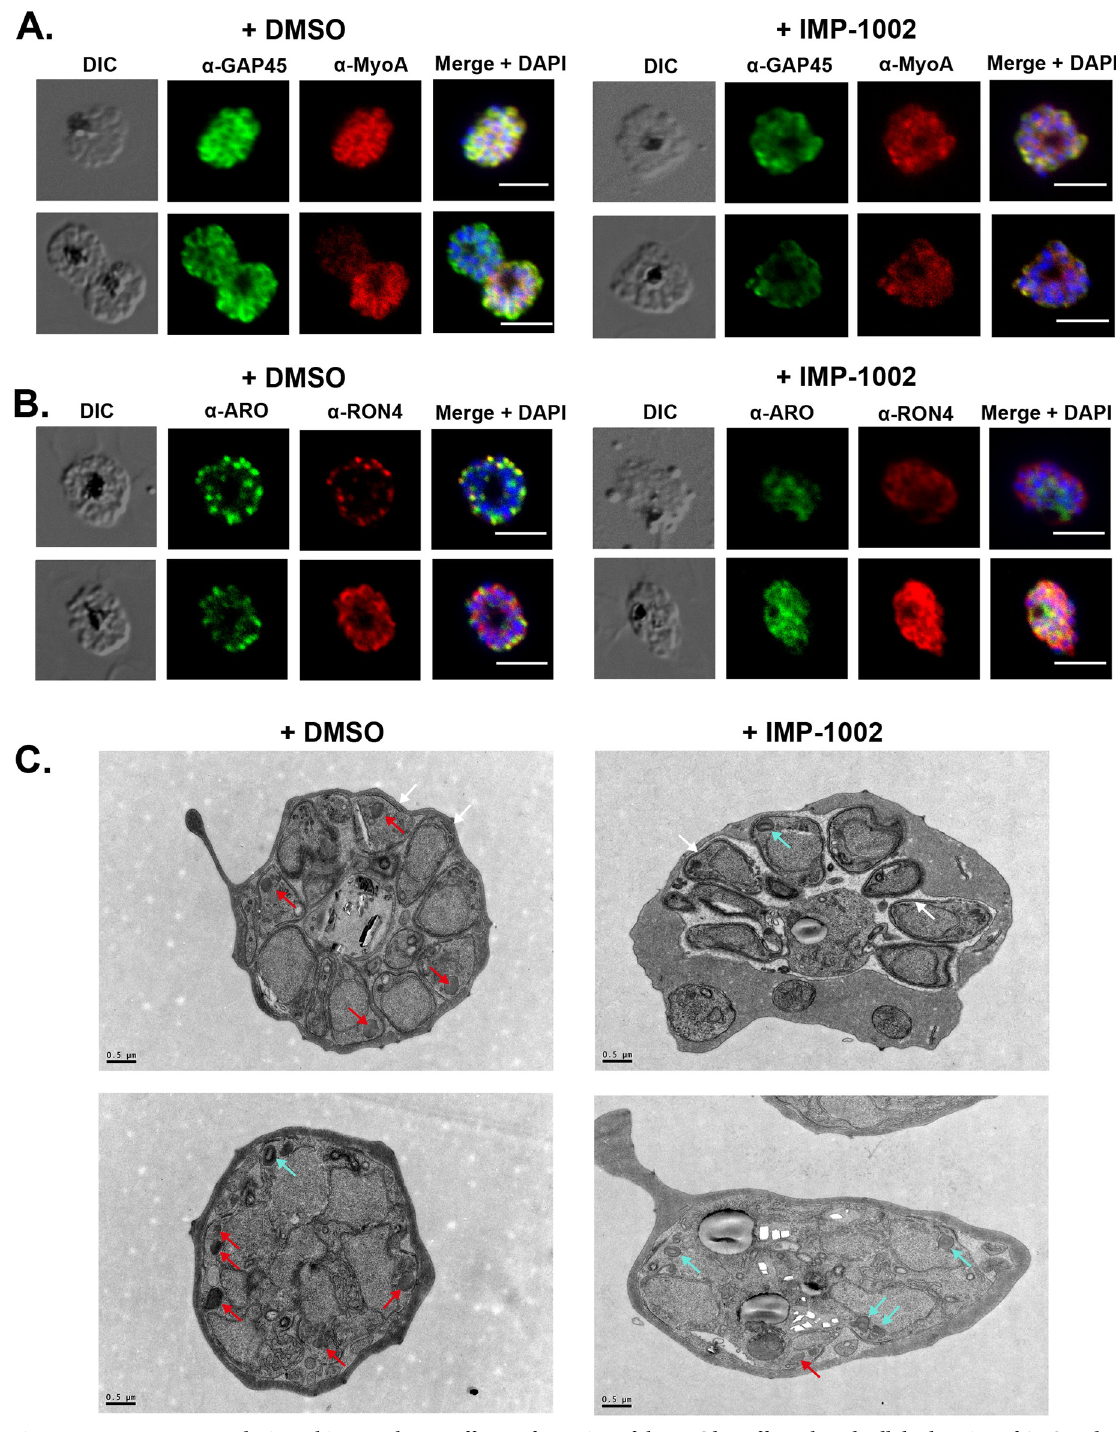
Fig 2. IMP-1002 treatment during schizogony has no effect on formation of the IMC but affects the subcellular location of ARO and RON4 and rhoptry biogenesis. Light microscopy images from indirect IFAs performed in duplicate on 3 separate occasions with fixed parasites from DMSO (control) and IMP-1002–treated parasites and protein-specific antibodies. Panels show the DIC image, the specific antibody location (green or red), and a merged image of antibody staining with DAPI staining of nuclei. Scale bar = 5 μ m. (A) Two examples showing that the location of GAP45 and MyoA at the IMC appeared largely unchanged following drug treatment. (B) Two examples showing that the location of ARO and RON4 was affected by drug treatment, with the proteins appearing to be distributed throughout the cytoplasm of developing merozoites and a loss of distinct rhoptry staining in treated parasites. (C) Transmission electron